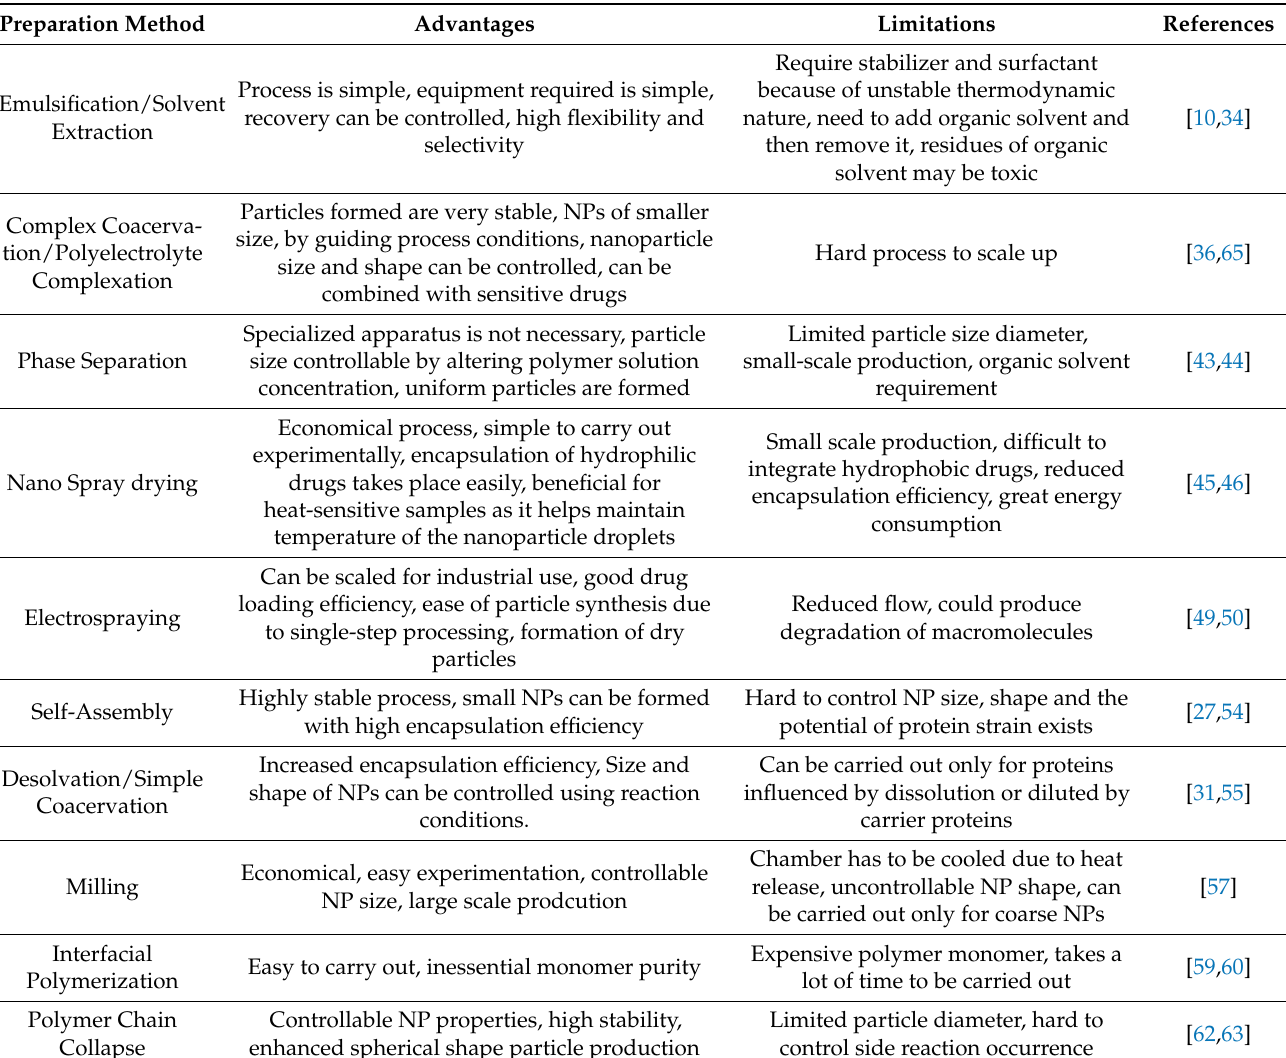
Table 1. Advantages and limitations of collagen NP preparation methods.